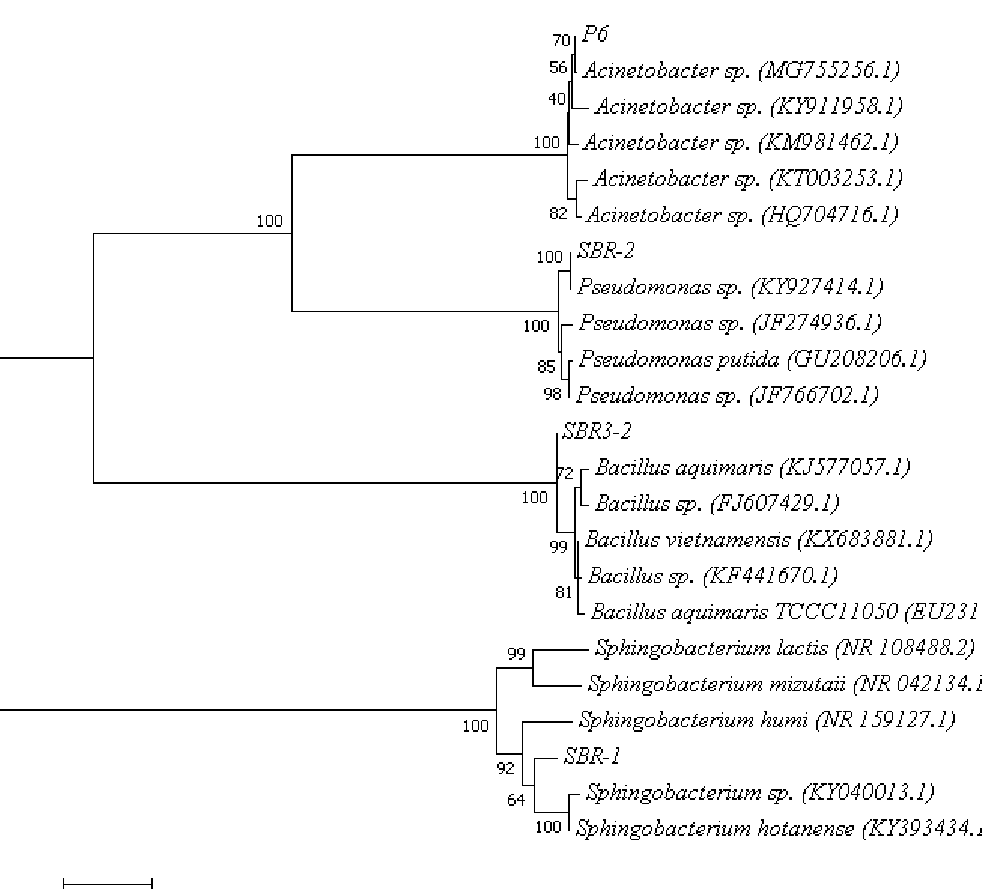
Figure 1. Phylogenetic tree based on 16S rDNA sequences of the isolates and related standard bacteria.